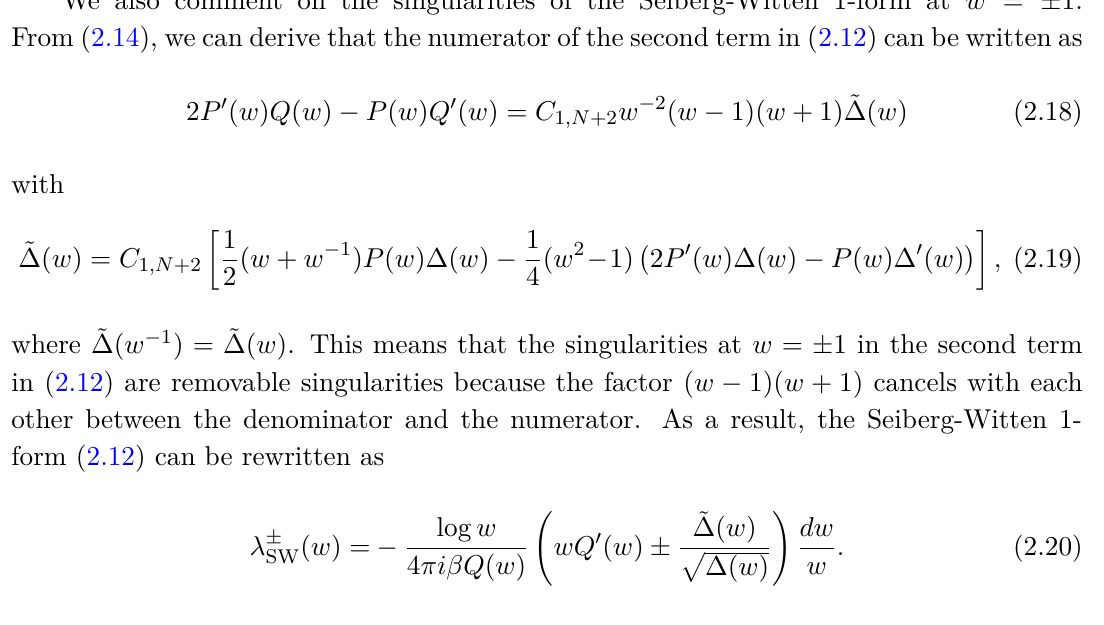
Figure 3 . A I , B I , and M i -cycles depicted on the two copies of complex plane with coordinate ( w ) is defined on the upper complex plane while λ − w . λ + SW plane. The two complex planes are connected at the branch cuts and they give the Seiberg-Witten curve as a